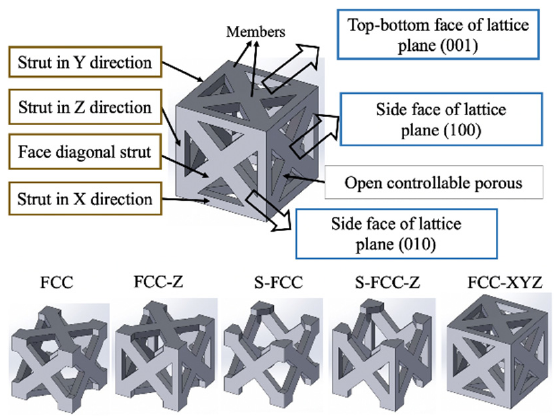
Figure 1. Five types of FCC based lattice structure design.